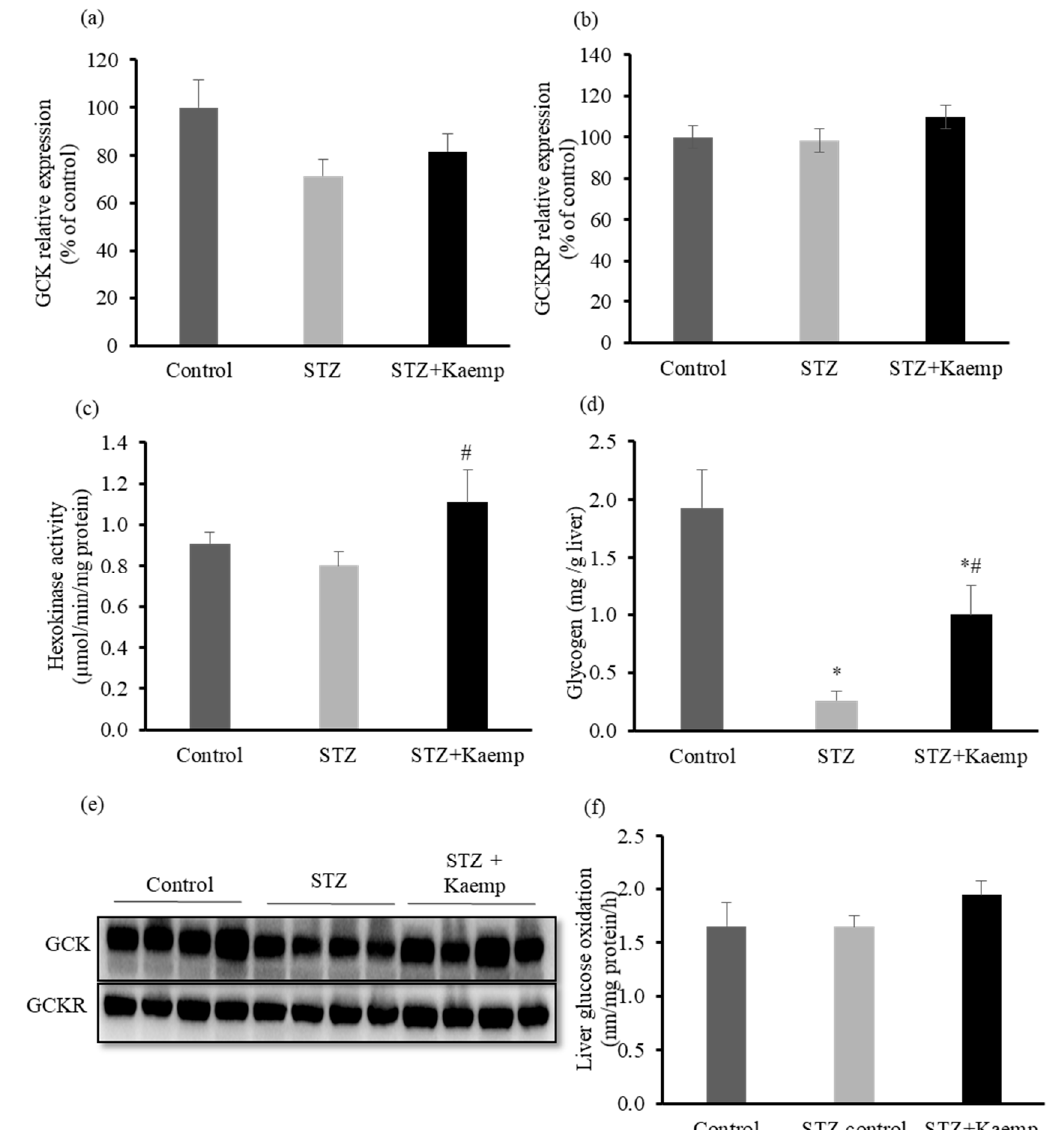
Figure 6. Kaempferol increased GCK activity and glycogen contents in STZ-induced diabetic mice. Diabetic mice were treated with kaempferol for 12 weeks. ( a , e ) Hepatic GCK, and ( b , e ) GCKRP protein levels were measured by Western blot and normalized to total protein contents. Hexokinase activity ( c ) and glycogen content ( d ) in the liver were measured as described in the Method section. ( f ) Glucose oxidation was evaluated in fresh mouse liver homogenates using 14 C-labeled glucose as described in the Method section. Data are shown as Mean ± SEM ( n = 8–9). * p < 0.05 vs. non-diabetic mice; # vs. STZ-induced diabetic mice. Control: nondiabetic mice; STZ: STZ-induced diabetic mice; STZ + Kaemp: STZ-induced diabetic mice treated with kaempferol (50 mg/kg